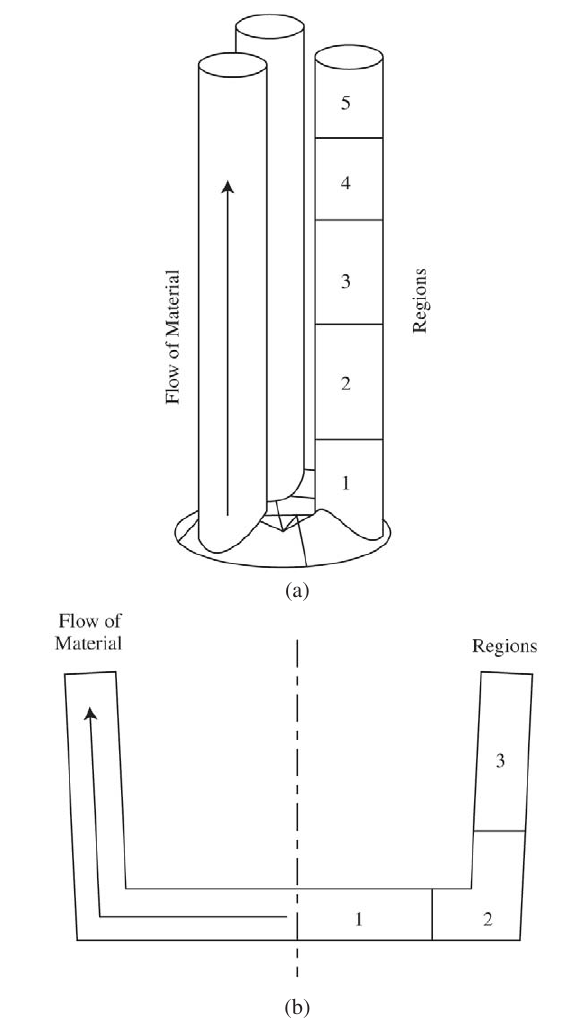
Figure 3. a) Schematic of the three rods assembly and b) of the cup.(b) cylindrical cup, showing the regions into which the samples were Figure 2. Two different views of the thixoformed divided for microstructural and defects